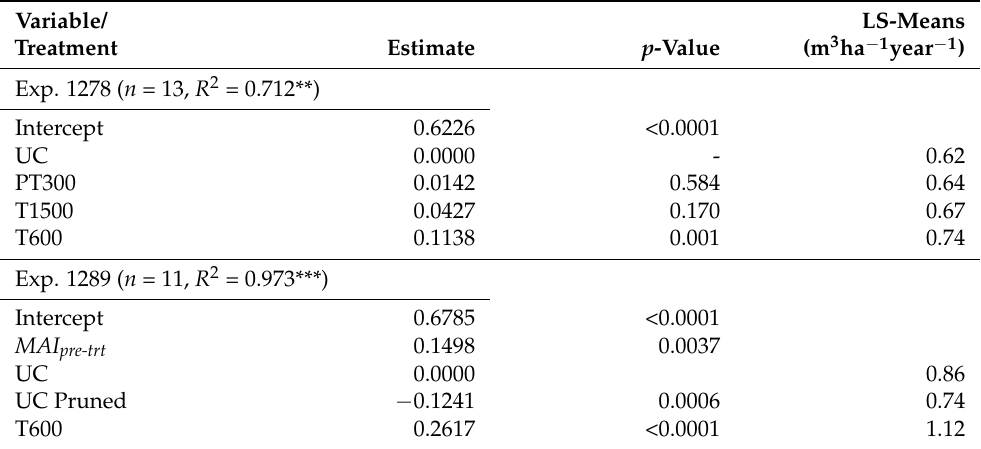
Table 6. Parameter and LS-means estimates for the final model of mean annual change in D 300 ( I D 300 ) depending on treatment and pre-treatment MAI. Legend: n = number of observations, R 2 = coefficient of determination.